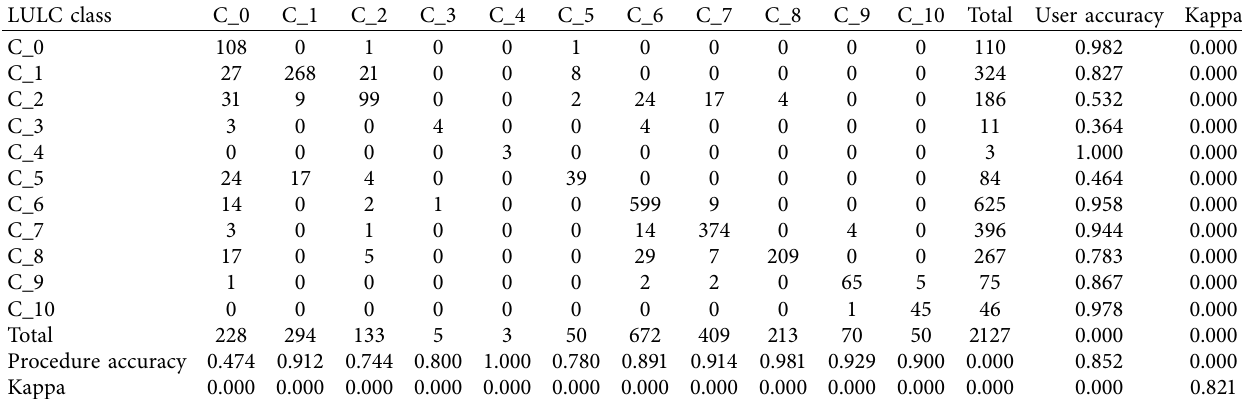
Table 5: Results of the accuracy assessment for the LULC classification based on the RF classifier with the MaSegFil